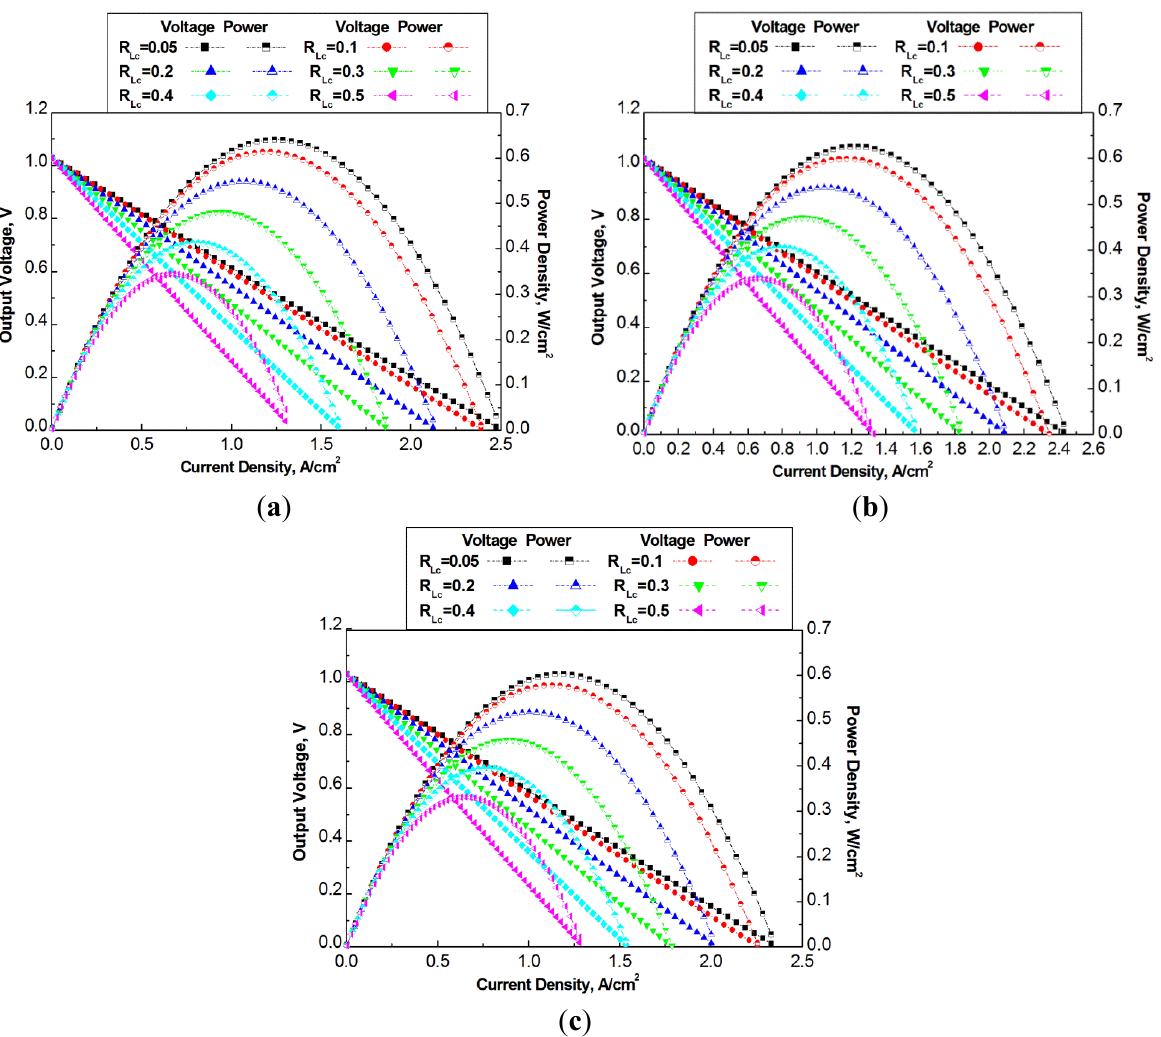
Figure 6. Cell voltage and power density versus current density at cell temperature